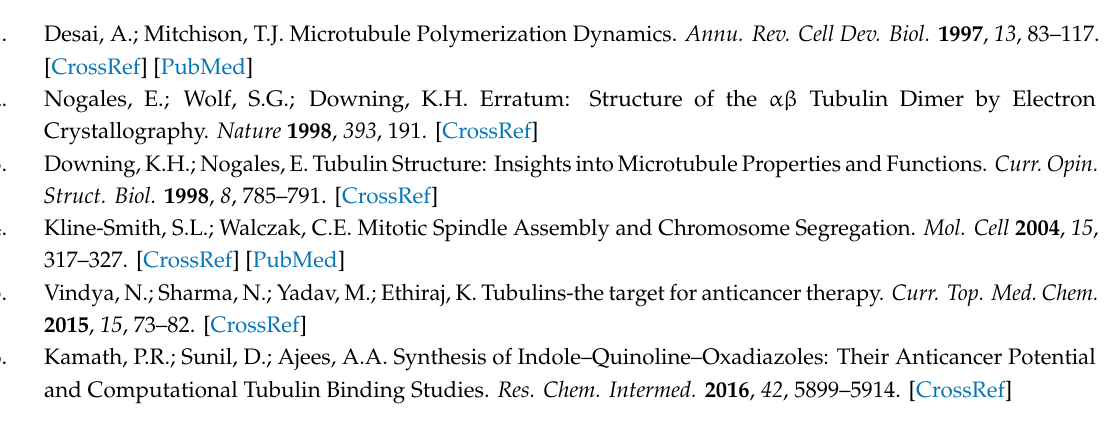
Figure S1: 1 H NMR for compound 19a , Figure S2: 13 C NMR for compound 19a , Figure S3: 1 H NMR for compound 19b , Figure S4: 13 C NMR for compound 19b , Figure S5: 1 H NMR for compound 19c , Figure S6: 13 C NMR for compound 19c , Figure S7: 1 H NMR for compound 19d , Figure S8: 13 C NMR for compound 19d , Figure S9: 1 H NMR for compound 19e , Figure S10: 13 C NMR for compound 19e , Figure S11: 1 H NMR for compound 19f , Figure S12: 13 C NMR for compound 19f , Figure S13: 1 H NMR for compound 19g , Figure S14: 13 C NMR for compound 19g , Figure S15: 1 H NMR for compound 19h , Figure S16: 13 C NMR for compound 19h , Figure S17: 1 H NMR for compound 19i , Figure S18: 13 C NMR for compound 19i , Figure S19: 1 H NMR for compound 19j , Figure S20: 13 C NMR for compound 19j , Figure S21: 1 H NMR for compound 20a , Figure S22: 13 C NMR for compound 20a , Figure S23: 1 H NMR for compound 20b , Figure S24: 13 C NMR for compound 20b , Figure S25: 1 H NMR for compound 20c , Figure S26: 13 C NMR for compound 20c , Figure S27: 1 H NMR for compound 20d , Figure S28: 13 C NMR for compound 20d , Figure S29: 1 H NMR for compound 20e , Figure S30: 13 C NMR for compound 20e , Figure S31: 1 H NMR for compound 20f , Figure S32: 13 C NMR for compound 20f , Figure S33: 1 H NMR for compound 20g , Figure S34: 13 C NMR for compound 20g , Figure S35: 1 H NMR f or compound 20h , Figure S36: 13 C NMR for compound 20h , Figure S37: 1 H NMR for compound 20i , Figure S38: 13 C NMR for compound 20i , Figure S39: 1 H NMR for compound 20j, Figure S40: 13 C NMR for compound 20j , Figure S41A–C: A. Quinoline 19b (yellow) and CA-4 (cyan) docked at the colchicine-binding site of tubulin in co-crystal 1SAO. B. Quinoline 20c (pink) and DAMA-colchicine (green) docked at the colchicine-binding site of tubulin in co-crystal 1SAO. C. Quinoline 9 = 20g (red) and CA-4 (cyan) docked at the colchicine-binding site of tubulin in co-crystal 1SAO. Protein residues removed on right for clarity. (red = oxygen, grey = hydrogen), Figure S42: 2D Ligand Interaction Schematic for 19b as generated by MOE, Figure S43: 2D Ligand Interaction Schematic for 20c as generated by MOE, Figure S44: 2D Ligand Interaction Schematic for 20g as generated by